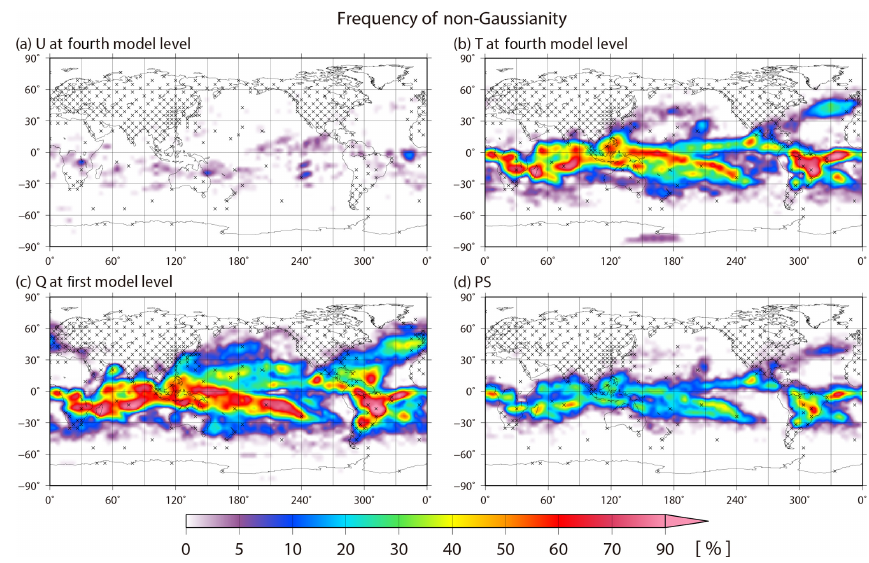
Figure 8. Spatial distributions of the frequency of the non-Gaussian PDF with high KL divergence D KL >0.01 for (a) zonal wind at the fourth model level, (b) temperature at the fourth model level, (c) specific humidity at the lowest model level, and (d) surface pressure. The frequency is defined as a ratio of high KL divergence D KL appearance from 00:00UTC on 25 January to 18:00UTC on 1 March. The crosses indicate the radiosonde-like locations.